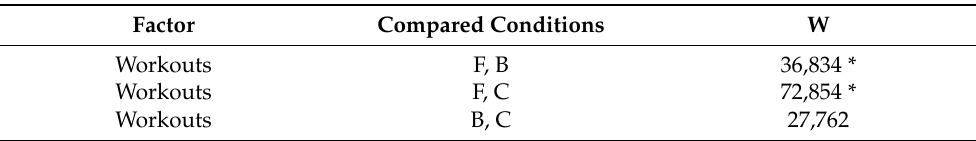
Table 4. Post-hoc Mann–Whitney tests results for the variable “Workouts” conducted on the whole sample. Factor Workouts Workouts B, C * p < 0.016 (Bonferroni correction).